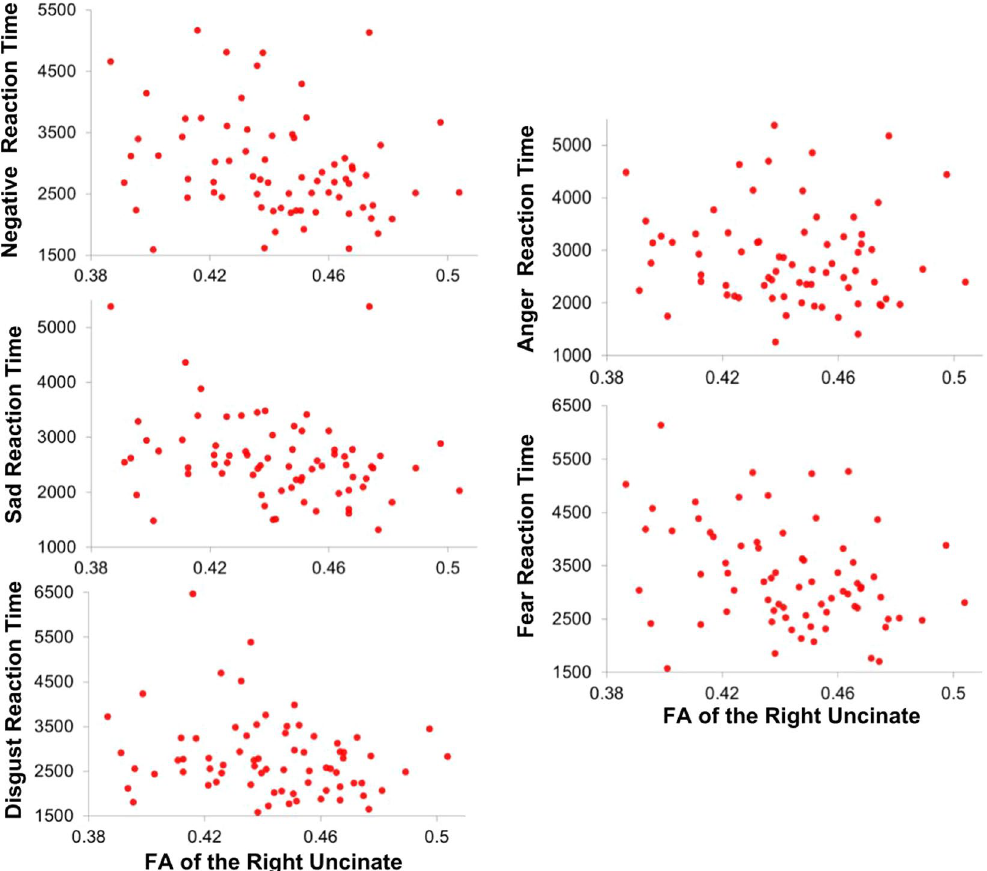
Figure 2. Relations between reaction time to emotional faces (ms) and fractional anisotropy (FA) of the right uncinate fasciculus. As all reaction times were non-normally distributed Spearman correlation was used to assess relations between FA of the uncinate fasciculi and reaction times to negative faces. FA of the right uncinate fasciculus was significantly correlated with reaction time to negative faces ( r s = − 0.26, p = 0.026). Subsequent analyses revealed that FA of the right uncinate fasciculus significantly negatively correlated with reaction time to sad ( r s = − 0.30, p = 0.010) and fearful faces ( r s = − 0.35, p = 0.003). FA of the right uncinate did not significantly correlate with reaction time to disgust faces ( r s = − 0.15, p = 0.218) or to anger faces ( r s = − 0.14, p =